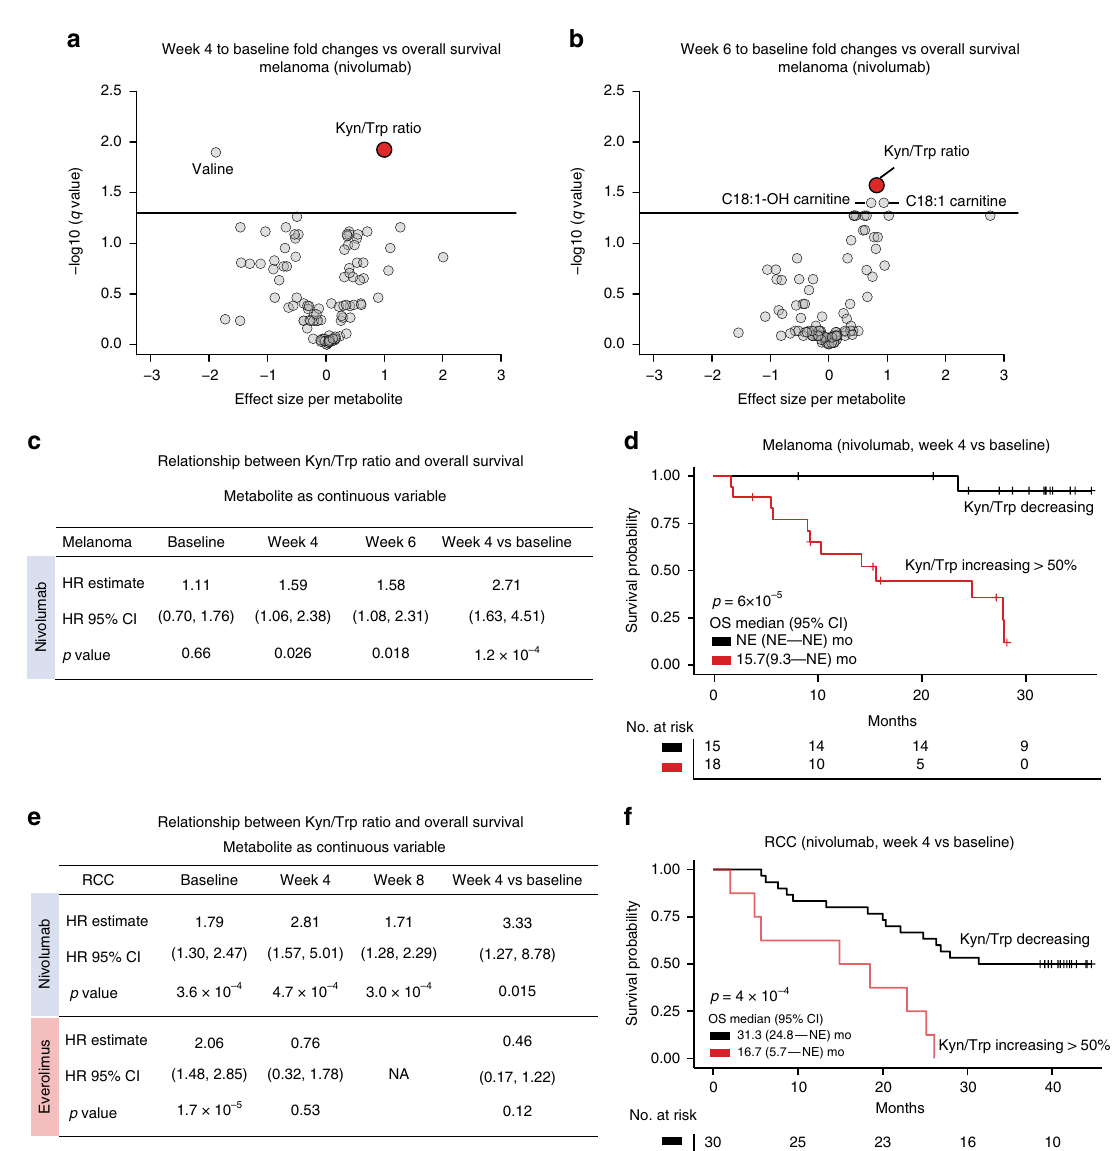
signi fi cantly associate with the melanoma patients ’ overall survival ( p = 0.66, HR = 1.11, 95% CI, 0.70 – 1.76, Cox model) but became signi fi cant at week 4 and week 6 (Fig. 3c). This was the case even after adjusting for patient demographic char- acteristics and BRAF mutational status (Supplementary Table 4). In particular, patients with a >50% increase in Kyn/ Trp had a median OS of 15.7 months while those with decreases had a median survival time of >38 months (Fig. 3d) ( p = 6.0 × 10 − 5 , log-rank test).